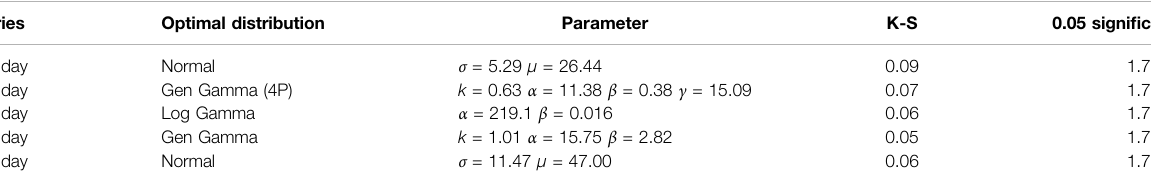
TABLE 3 | Optimal distribution of C1 day, C2 day, C3 day, C4 day, and C5 day.